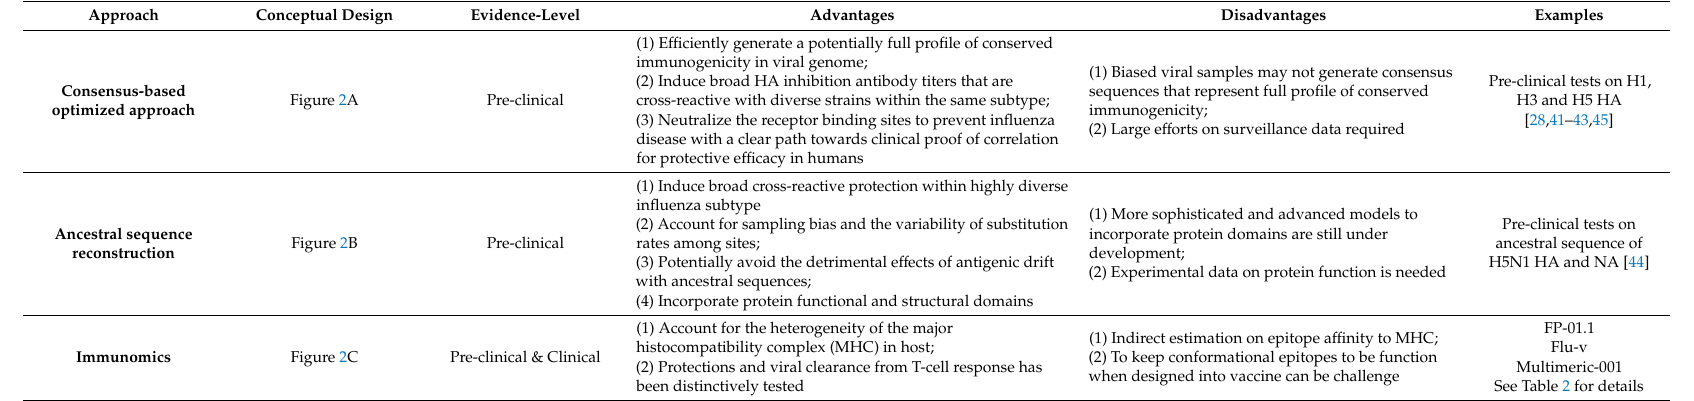
Table 1. Summary and examples of computational influenza universal vaccine